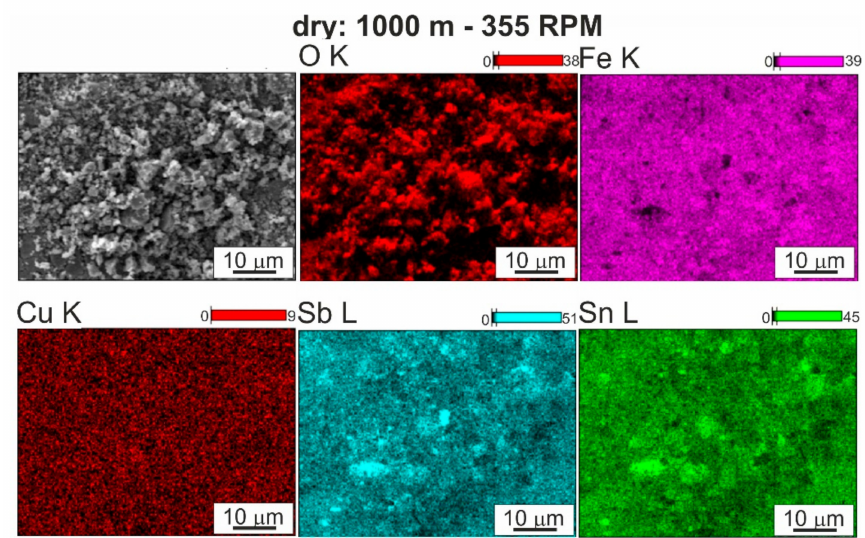
Figure 9. Surface after friction of SnSb11Cu6 alloy FSP modified using speed 355 RPM and map of distribution of elements: O, Fe, Cu, Sn, Sb; technically dry friction; SEM.